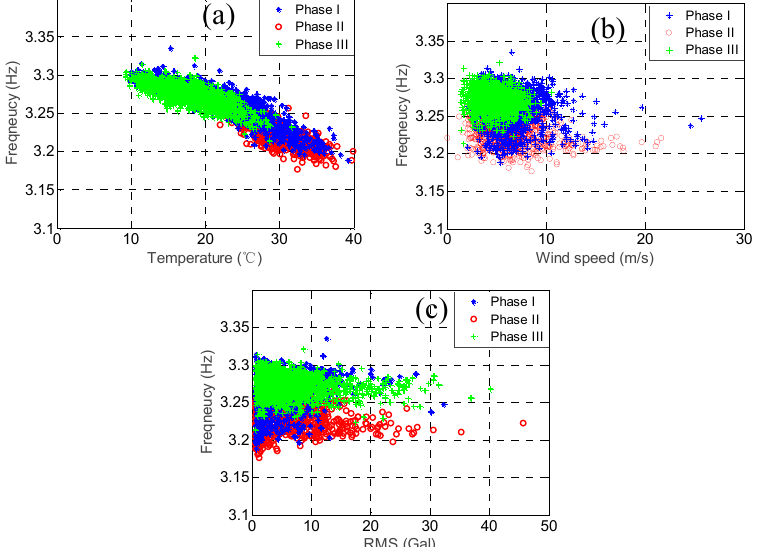
Figure 16. The relationship between the 4th modal frequency (3.26 Hz) and ( a ) temperature; ( b ) wind speed; and ( c ) RMS acceleration.